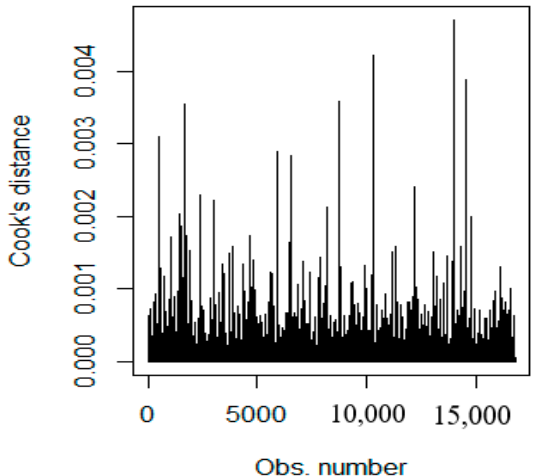
Figure 3. Cook’s distance. Table 4. Regression results from Model 1.